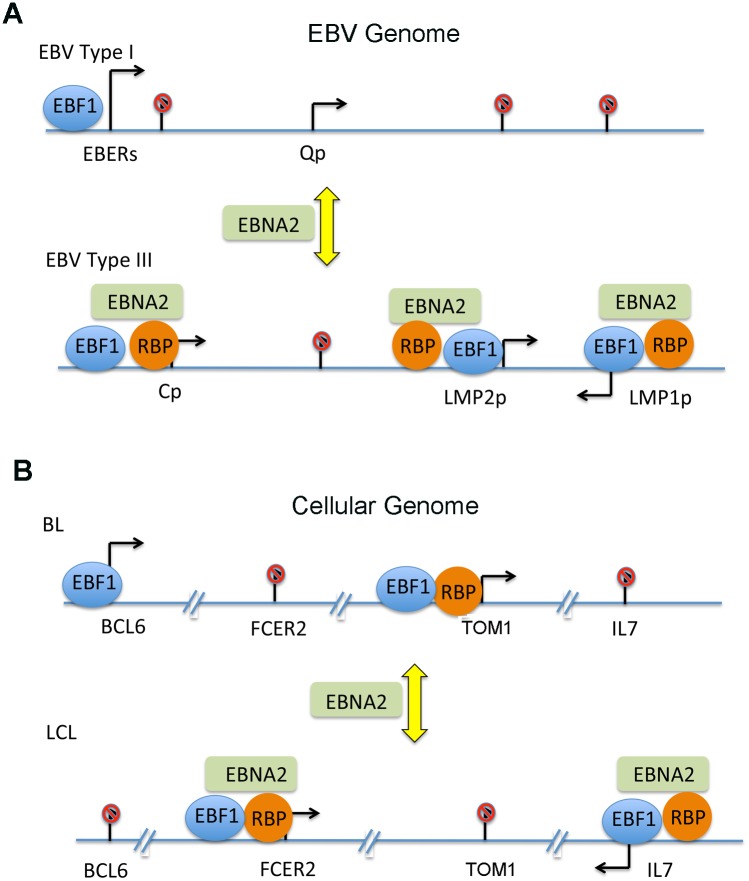
Model of EBNA2-induced transcription factor redistribution in chromosome occupancy.EBNA2 is shown to facilitate the formation of new binding sites that are co-occupied by RBP-jκ and EBF1 relative to cells lacking EBNA2.